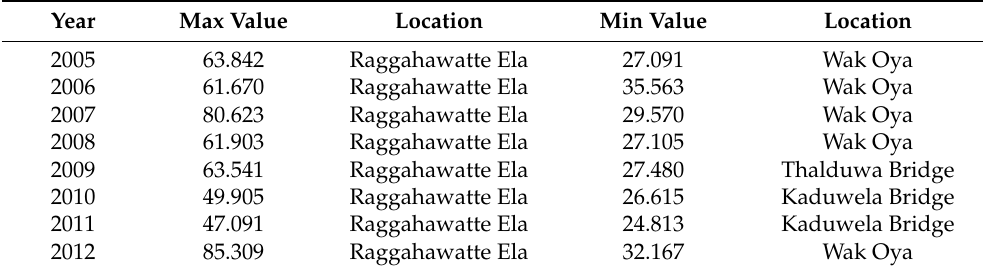
Table 3. Maximum and minimum values of WQI along the Kelani River.